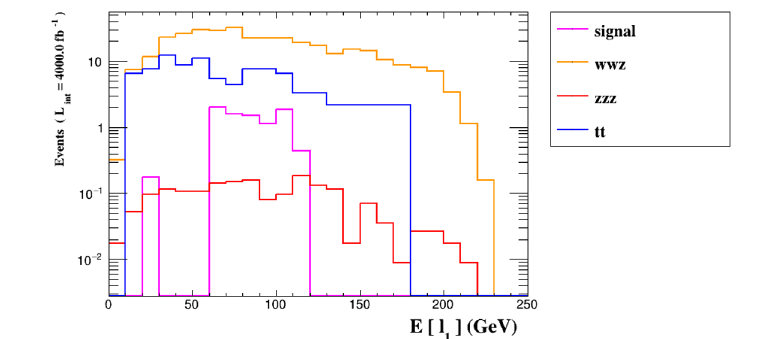
Figure 3 . The energy of the leading lepton ‘ 1 for our signal and different background components. The preselection of table 2 has been imposed.